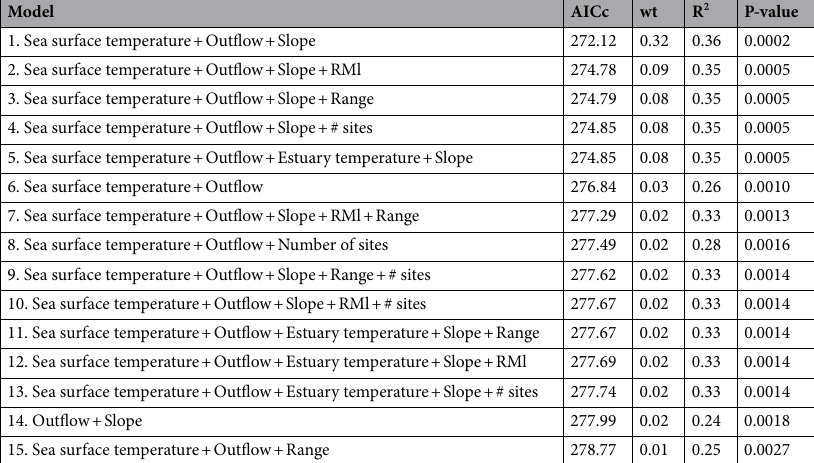
Table 2. Model results for the top fifteen models from lowest to highest AICc. The drivers tested for their influence on median migration date of Striped bass were spring ocean conditions (North Pacific Gyre Oscillation (NPGO), PDO, sea surface temperature, and upwelling index), estuarine hydrology (outflow and centroid day of outflow), estuary temperature, and sampling (upstream movement in sampling location (Slope), median river kilometer (RKm), range of days sampled (Range), and number of sites samples (# sites)). The AICc, AIC weight, adjusted R-squared and p-values are